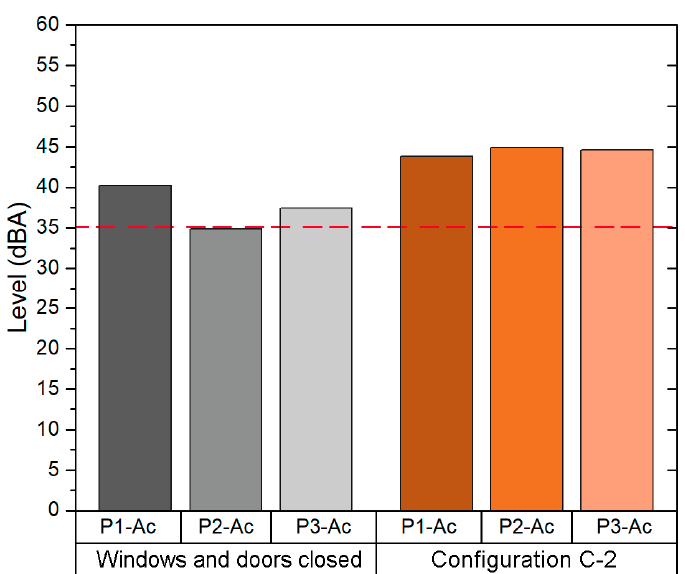
Figure 13. Ventilation rate (ACH) in Classroom B2-A2.